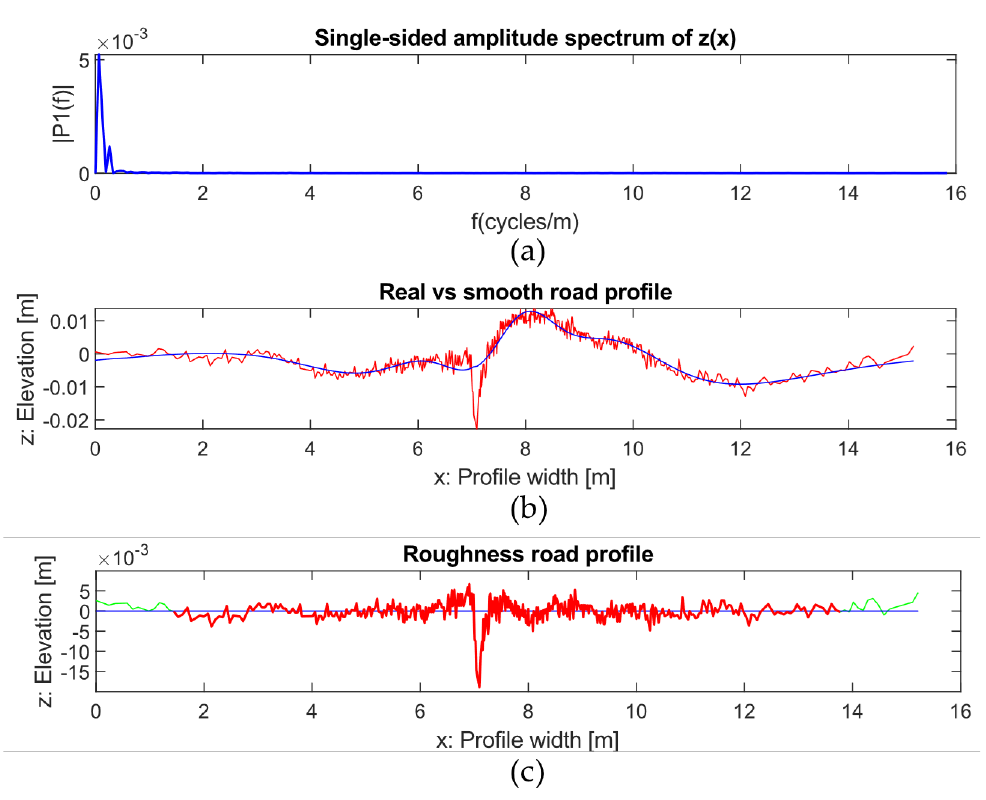
Figure 3. ( a ) Power spectral density of the function. ( b ) Original profile alongside the filtered pave- ment prime profile/shape profile. ( c ) Roughness road profile. pavement prime profile/shape profile. ( c ) Roughness road